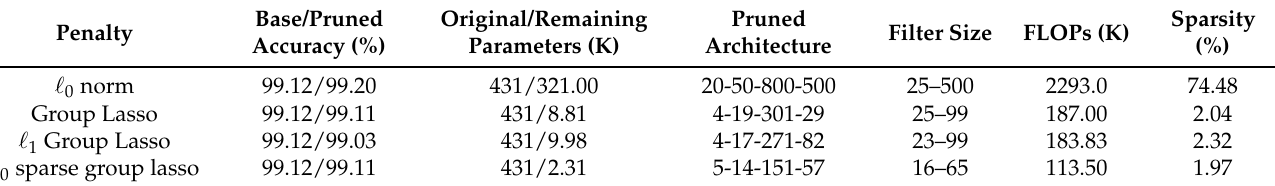
Table A3. Alation studies on LetNet-5 (Architecture: 20-50-800-500).